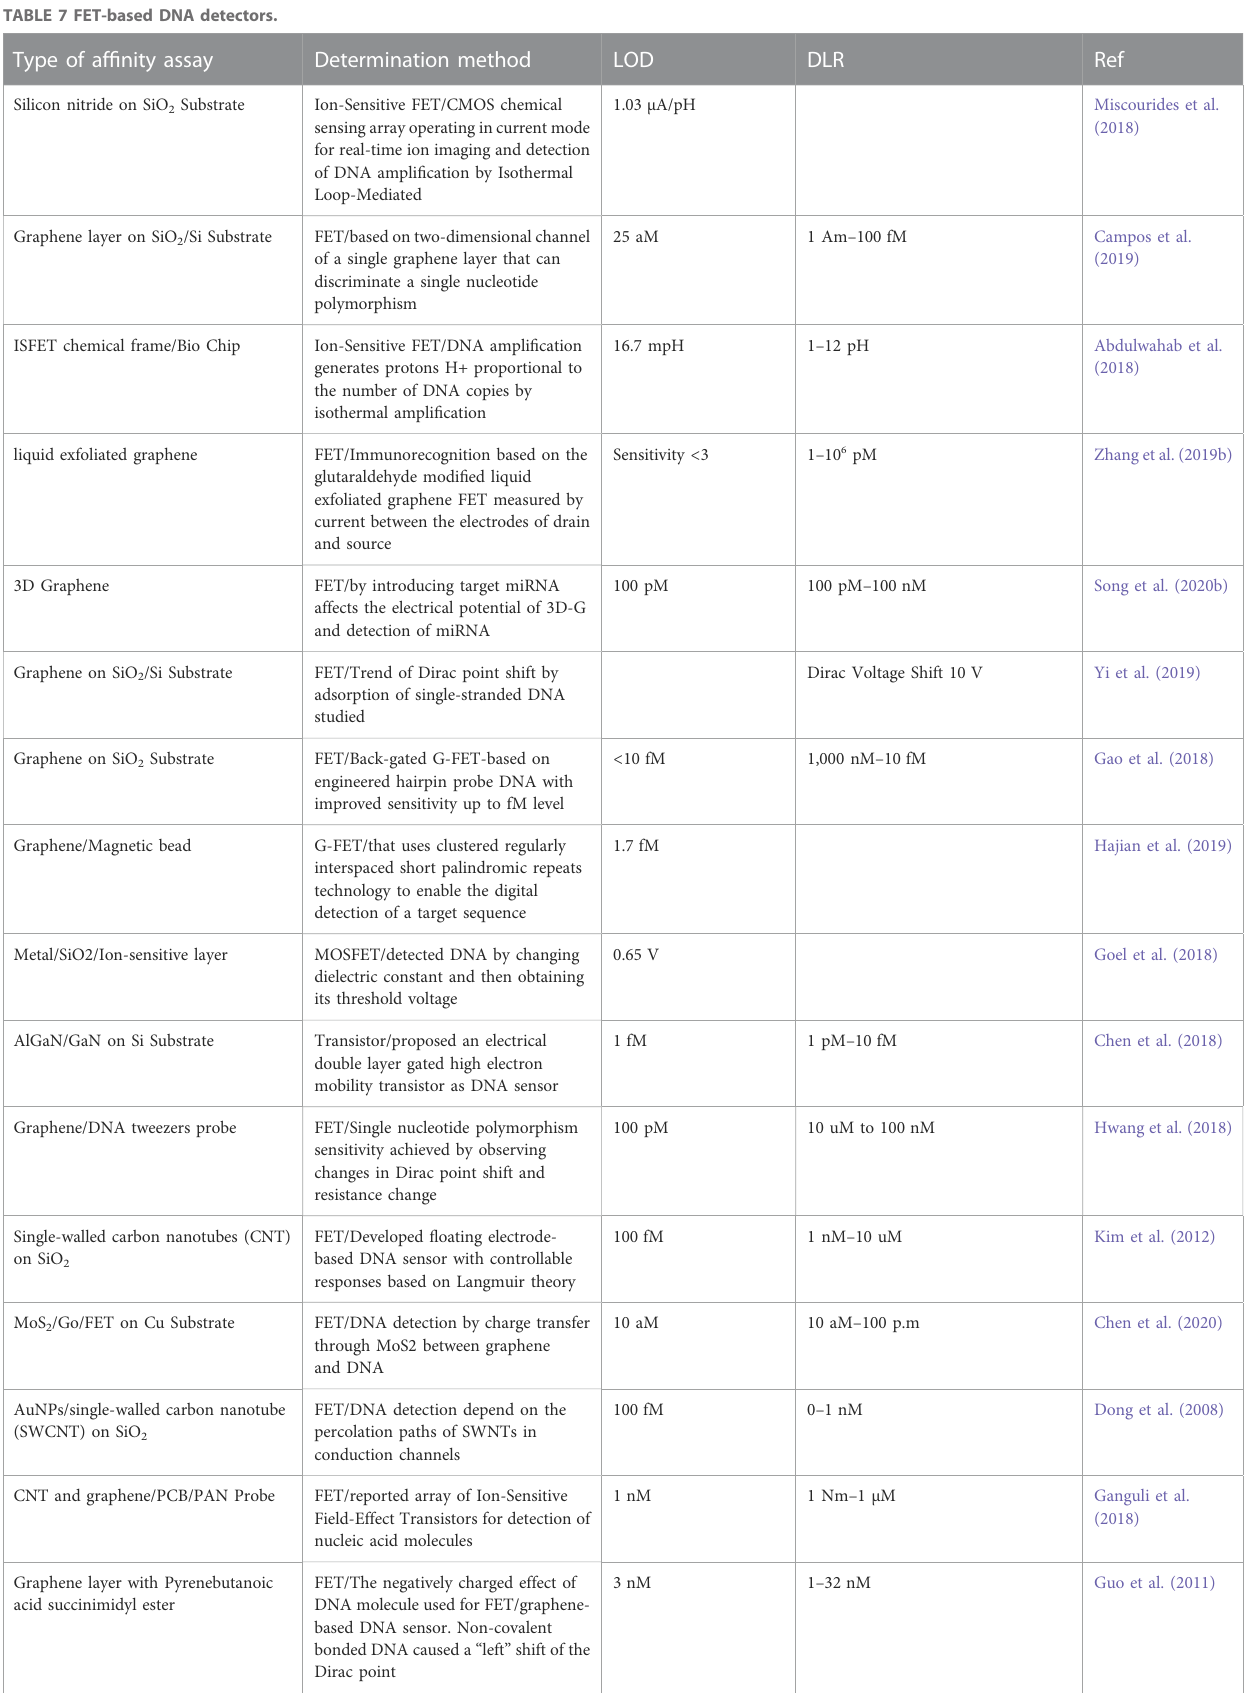
TABLE 7 FET-based DNA